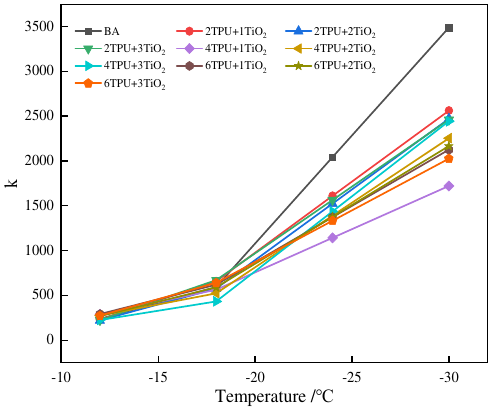
Figure 5. The curve of k with